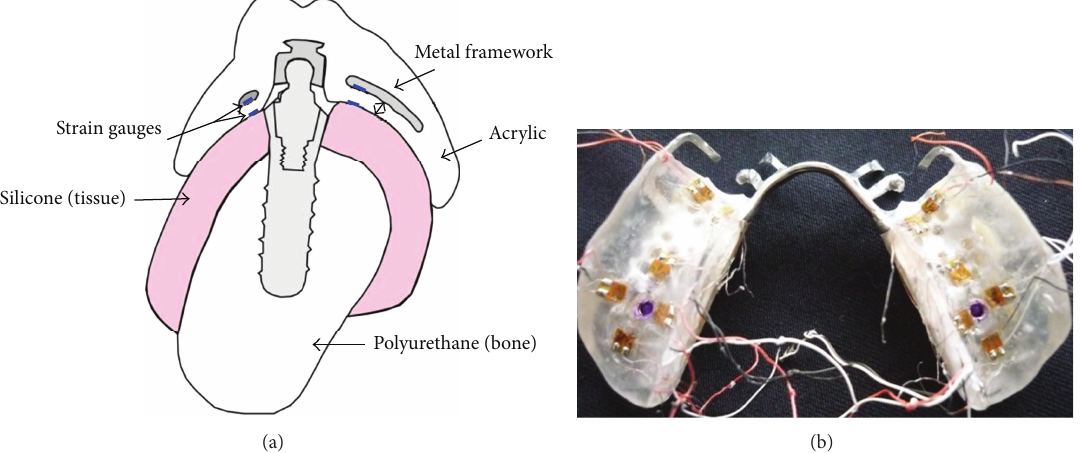
Figure 1: (a) Orientation of strain gauges on metal framework and acrylic surfaces. (b) Strain gauges placement on acrylic surface.